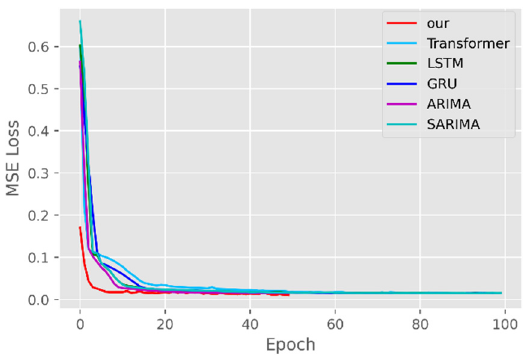
Figure 6. Comparison of training loss for CA cases and deaths.